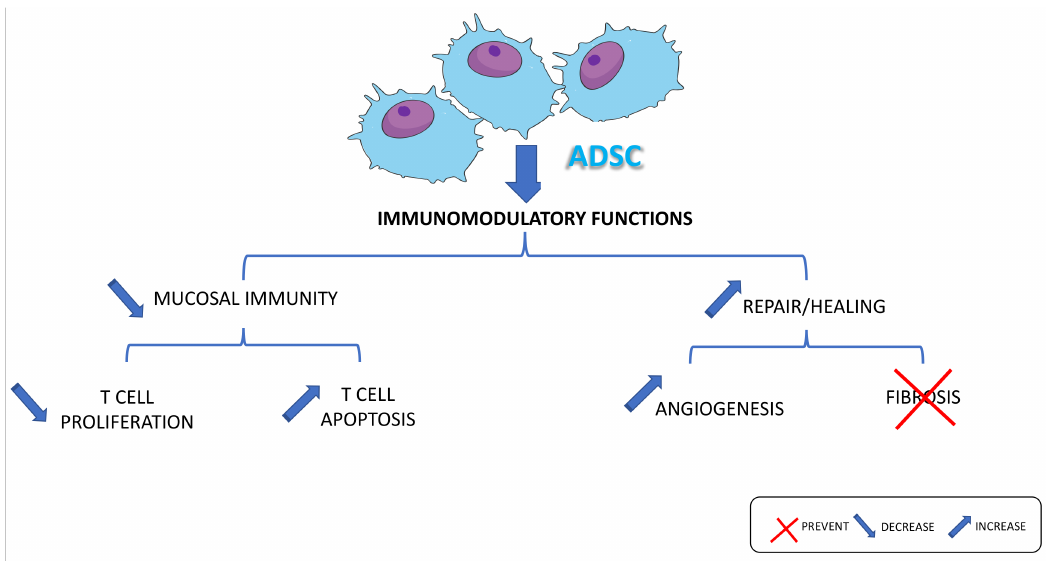
Figure 3. Mechanisms involved in adipose-derived stem cells (ADSCs)-associated beneficial effects in the inflamed